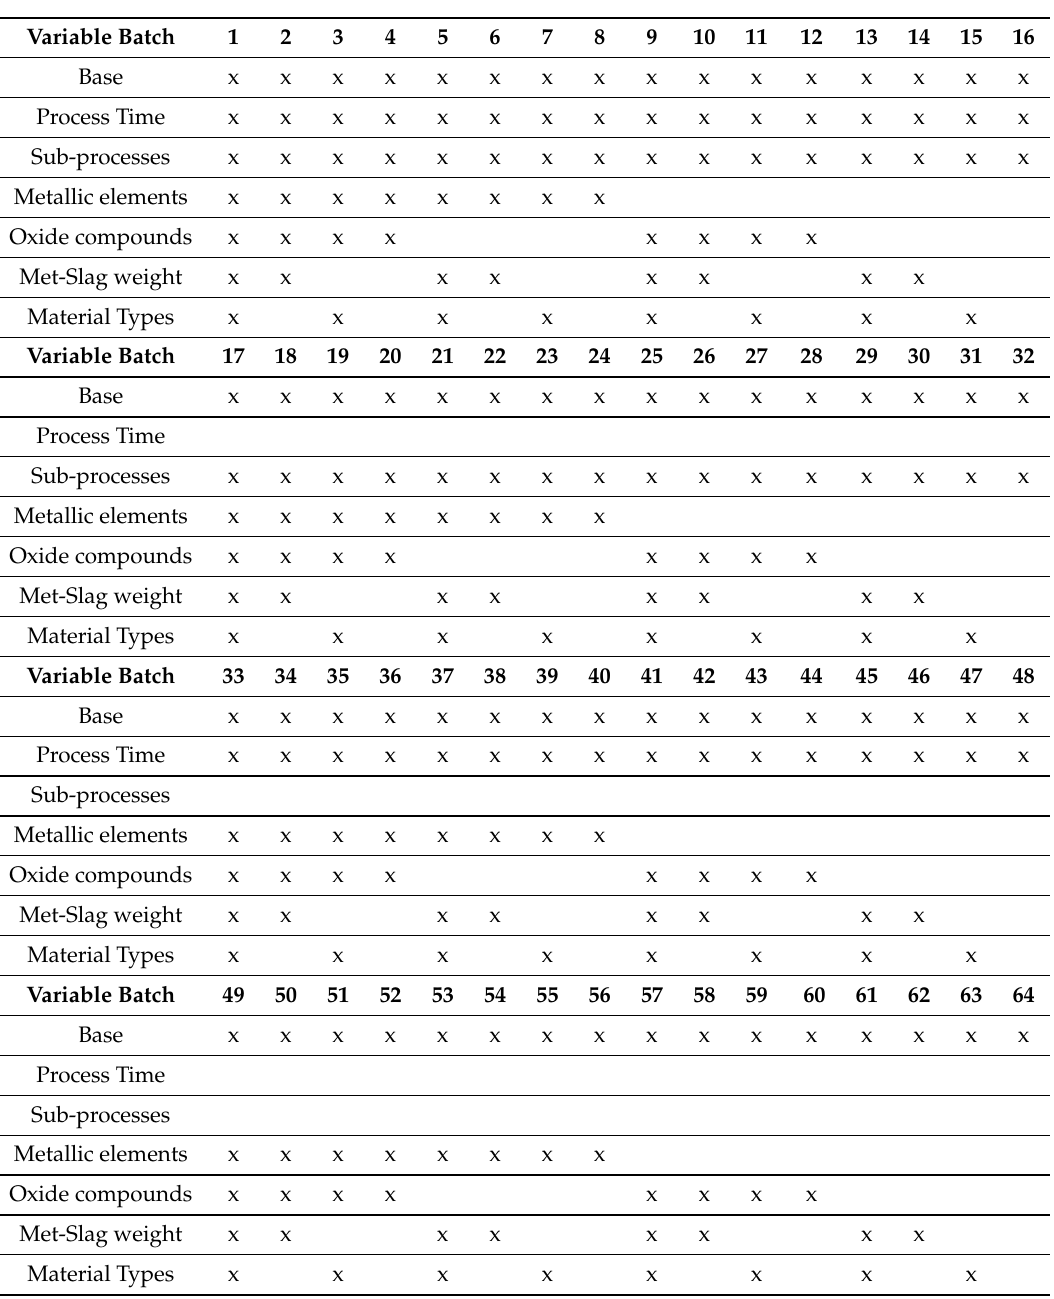
Table 4. The variable batches governing the domain-specific variable selection approach. The variables contained within each variable group are shown in Table